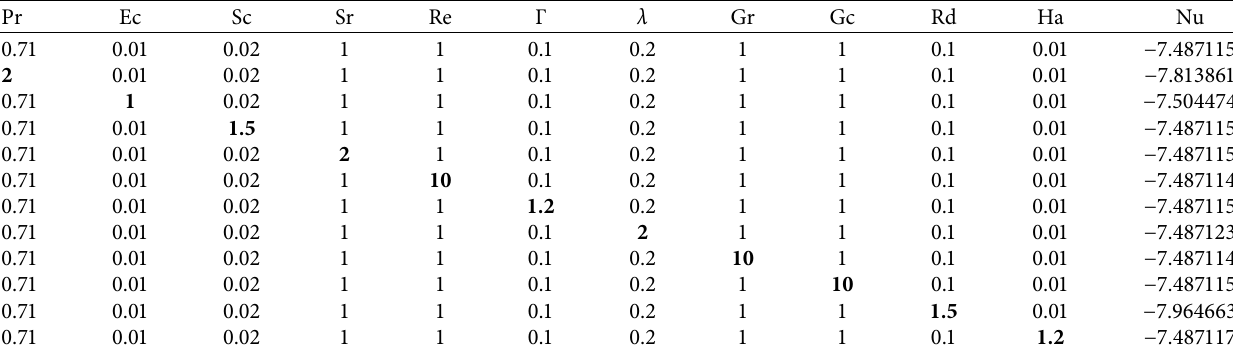
Table 2: Nusselt number for various values of parameters.